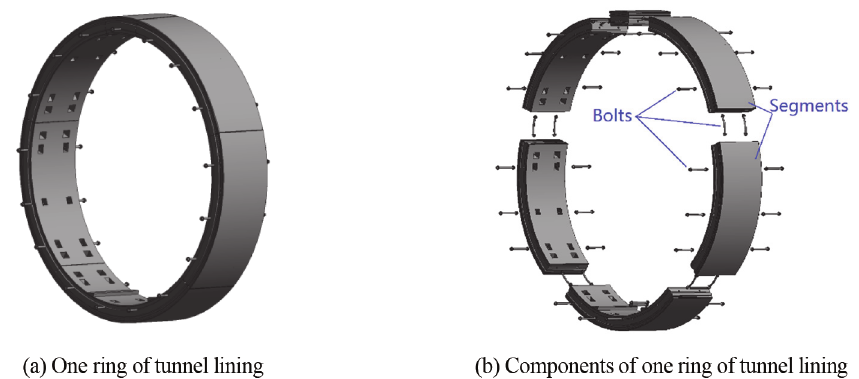
Figure 1. One ring of tunnel